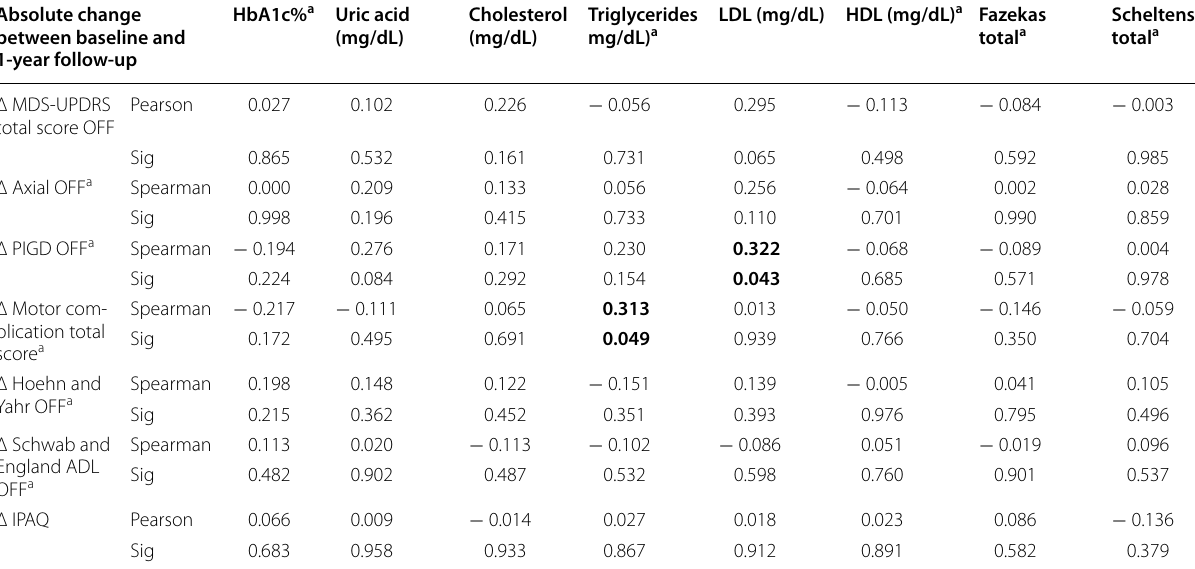
Bold values are significant